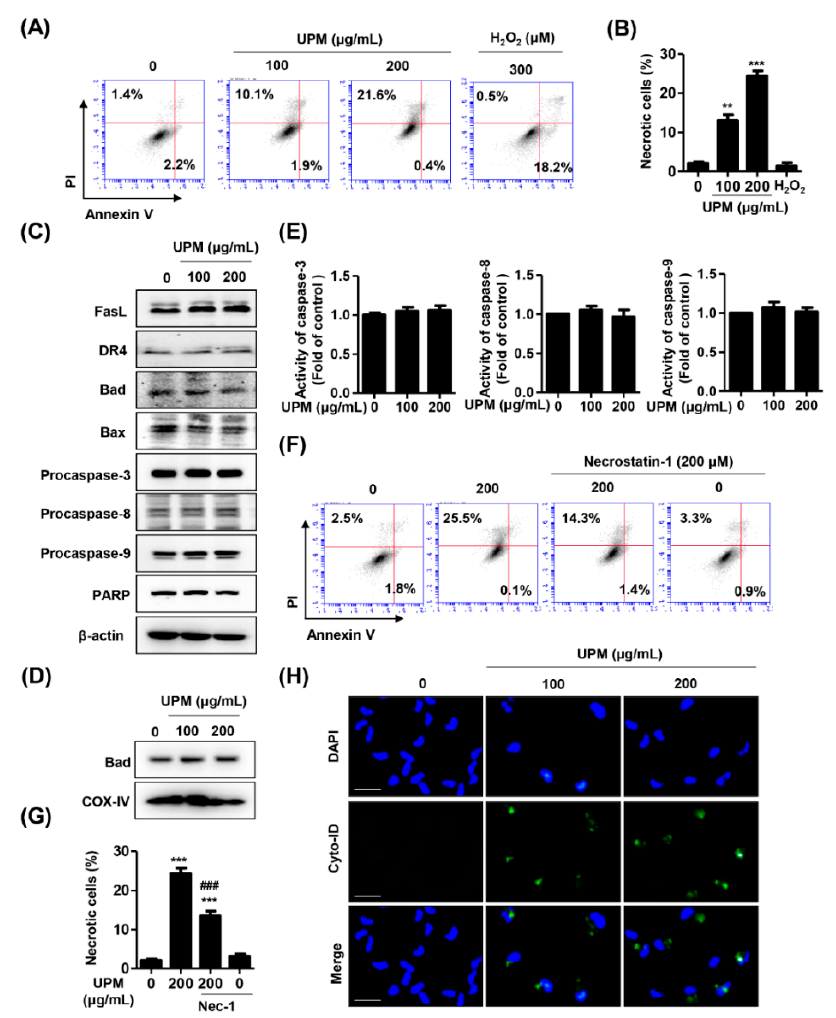
Figure 2. UPM induces necrosis and autophagy without apoptosis in ARPE-19 cells. ( A – E ) The cells were treated with the indicated concentration of UPM for 24 h. ( A ) The representative histograms of the cells stained with annexin V/propidium iodine (PI) and analyzed using a flow cytometer with necrotic cells identified as annexin V − /PI + cells (upper left quadrant) and apoptotic cells defined as annexin V-positive cells (lower left quadrant). ( B ) The percentages of necrotic cells. ( C ) The expression of apoptosis-regulatory proteins. ( D ) The expression of Bad in mitochondrial fraction. ( E ) Relative activities of caspase-3, -8, and -9. ( F ) The representative histograms of ARPE-19 cells pretreated with 200 µ M necrostatin-1 (Nec-1) for 1 h and incubated with 200 µ g/mL UPM for 24 h and were stained with annexin V/PI. ( G ) The percentages of necrotic cells. Data are expressed as the mean ± SD ( n = 5). ** p < 0.01 and *** p < 0.001 when compared to untreated cells. ### p < 0.001 compared to 200 µ g/mL UPM-treated cells. ( H ) Cyto-ID-stained cells (autophagic cells, green) and DAPI-stained cells (nuclei, blue) were captured under fluorescence microscopy. Scale bar: 75 µ